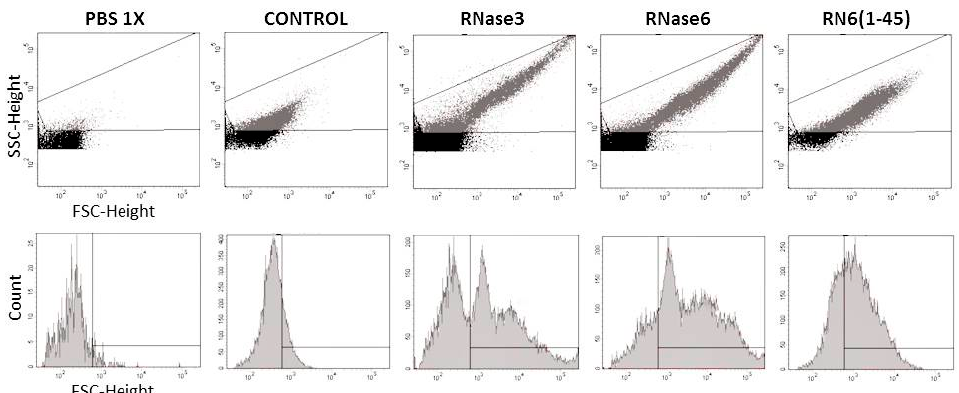
Figure 5. Bacterial agglutination measured by FACS. E. coli cultures were incubated in the absence and presence of RNase3, RNase6 and RN6(1–45) at a final concentration of 5 µM for 4 h. Low-angle forward scattering (FSC-H) is represented on the x -axis and the side scattering (SSC-H) on the y -axis to analyze the size and complexity of the cell cultures. Plots show density of cell population distribution. Buffer background is shown in black and cell population in grey.